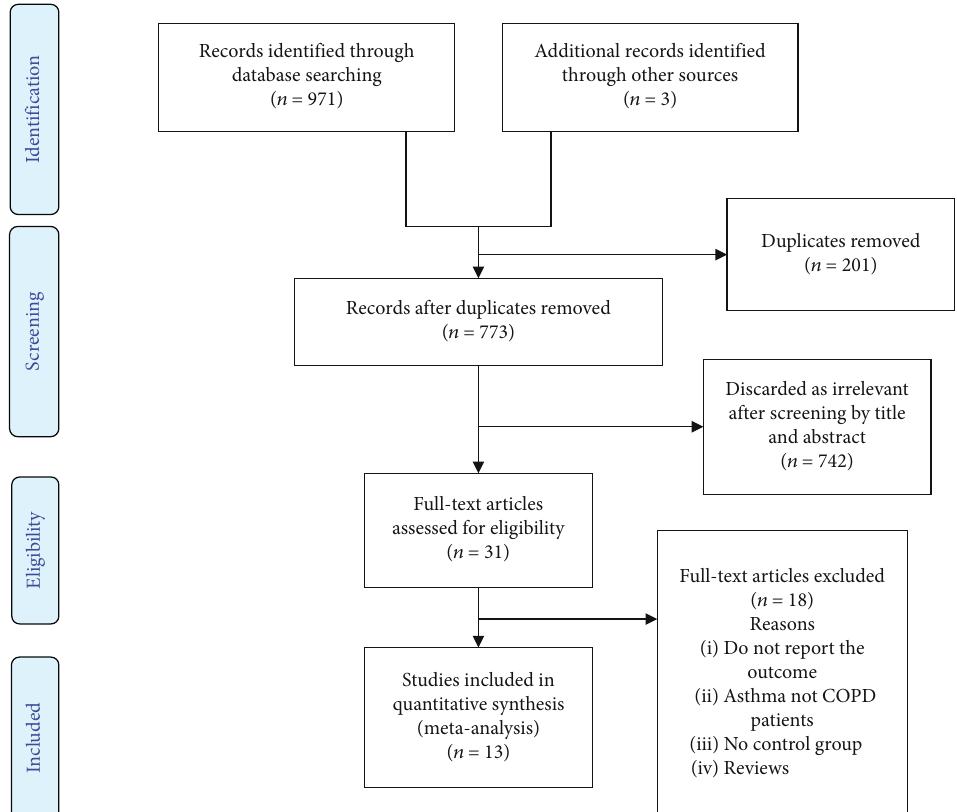
Figure 1: PRISMA fl ow diagram of study selection to estimate HR for risk of lung cancer among COPD patients taking ICS and